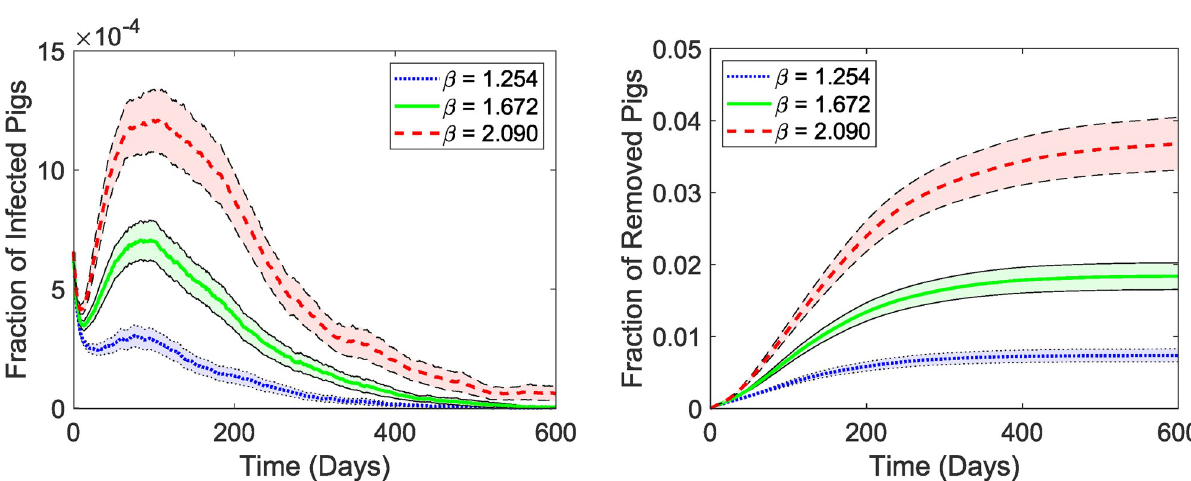
Fig 4. Time series outbreak results. Simulated outbreak dynamics in the generated swine network. The results shown above are the averages of 1000 independent simulations. To start each outbreak, a herd/farm was selected uniformly at random where we infected up to 10 pigs which were selected randomly from that particular herd. The simulations were run for three different β values (1.672, 1.254, and 2.090) which are shown using different line styles and colors as indicated by the legends. The shaded regions in the plots show 95% confidence intervals. The left plot shows the fraction of infected pigs and the right plot shows the fraction of removed (dead) pigs over time for the generated pig